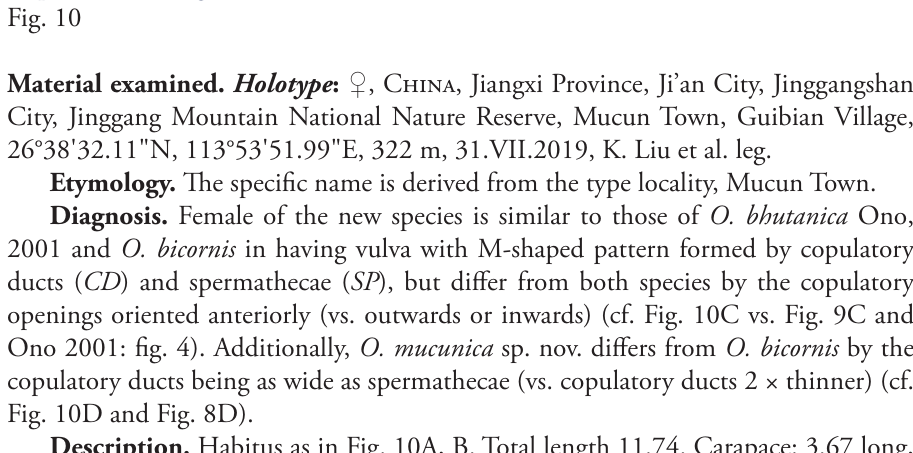
Material examined. Holotype : ♀ , China, Jiangxi Province, Ji’an City, Jinggangshan City, Jinggang Mountain National Nature Reserve, Mucun Town, Guibian Village, 26°38'32.11"N, 113°53'51.99"E, 322 m, 31.VII.2019, K. Liu et al.